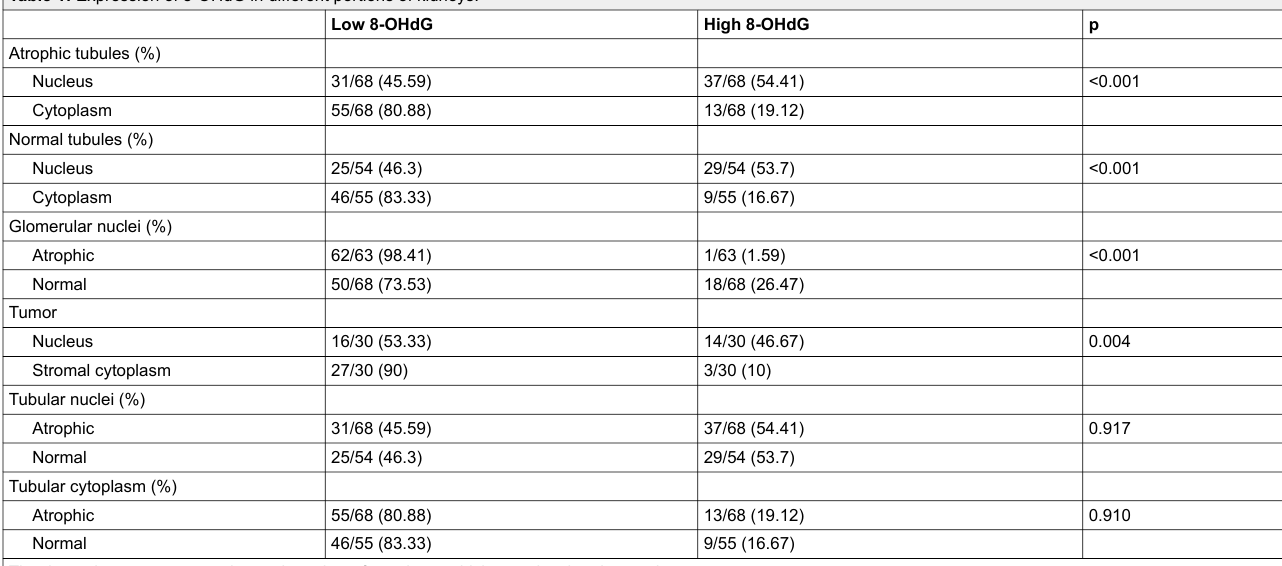
Table 1: Expression of 8-OHdG in different portions of kidneys.